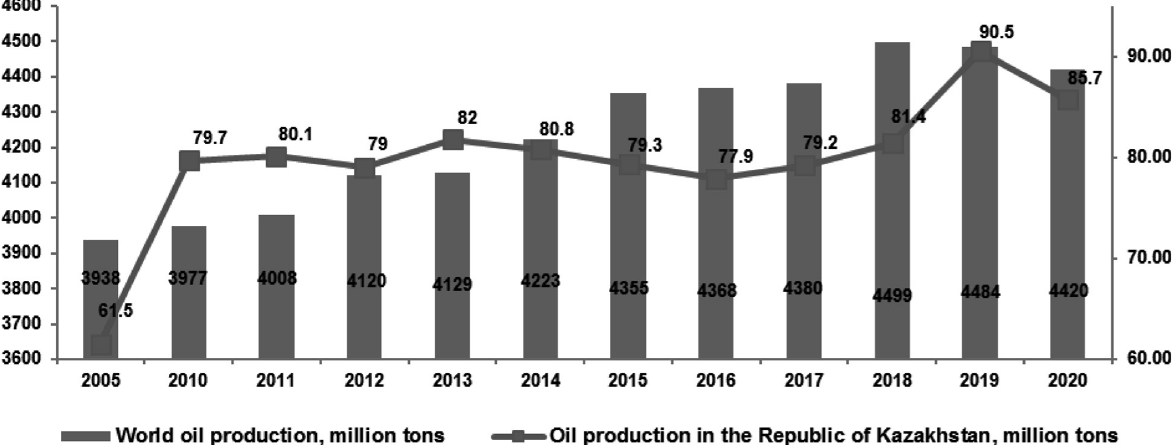
Fig. 1. Oil production in the